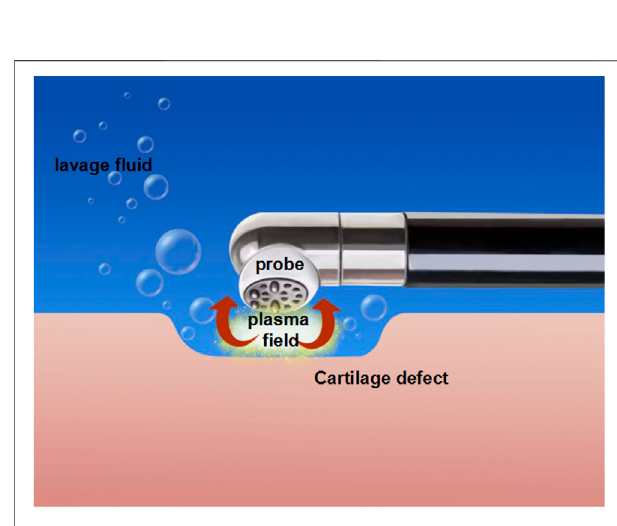
FIGURE 1 | Radiofrequency debrides the damaged cartilage surface to create a smooth cartilage surface. After treatment, MMP-13 tissue immunoreactivity increases,whichmayleadtoanegativeshiftinthebalancebetweensynthesisanddegradationoftheECM.IL-6playsaroleinpromotingandinhibiting thechondrocyte proliferation.IL-6andIL-8promotetheproliferationofmesenchymalstemcell.Mesenchymalstemcellscandifferentiateintochondrocytesandenhancecartilagerepair. Secretion of MMP-1 and MMP-2 is signi fi cantly reduced, which may help prevent further degradation. Red lines (cid:1) Stimulating; Green lines (cid:1) Suppressing; Black line (cid:1) Differentiation.